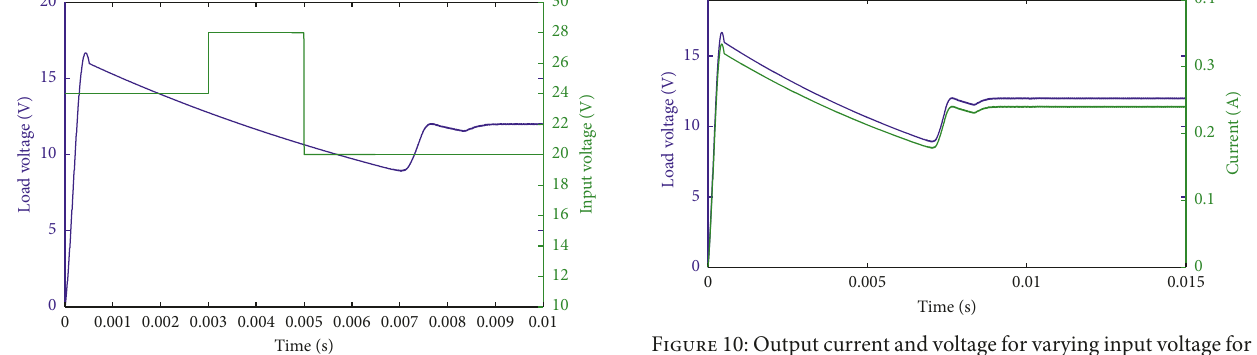
Figure 9: Output voltage across load under variable input voltage for ZN-PID controller.